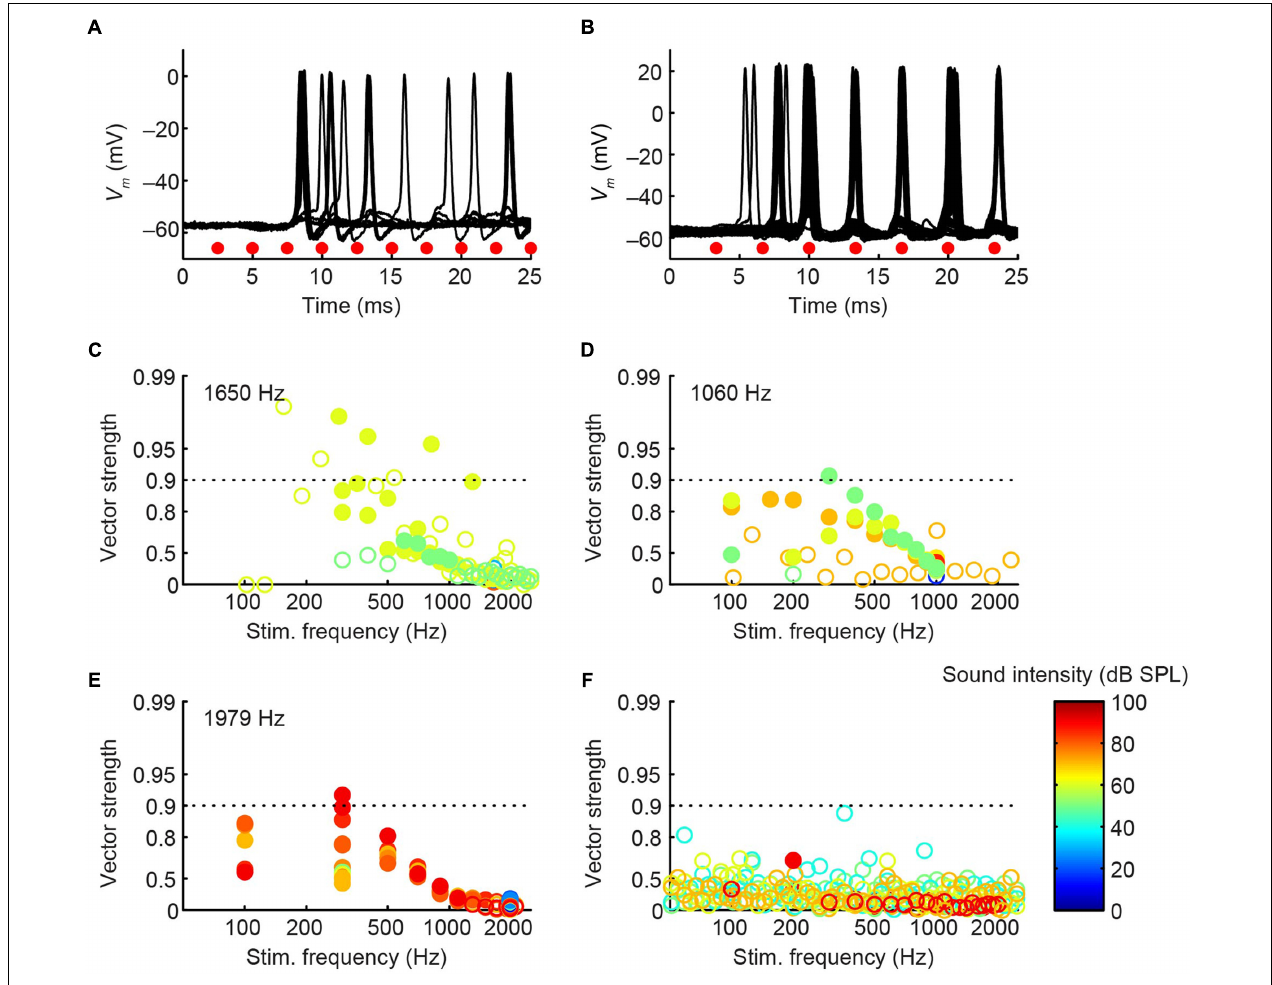
FIGURE 12 | Phase-locking of pvLNTB neurons to tones. (A) Stacked responses of a pvLNTB neuron to 400 Hz tones at 60 dB SPL (CF = 1650 Hz). Red dots indicate stimulus periods. VS is 0.78 ( α ≤ 0.001). (B) Responses of another pvLNTB neuron (CF = 1060 Hz) to 300 Hz tones at 50 dB SPL. VS is 0.91 ( α ≤ 0.001). (C–F) VS as a function of stimulus frequency for four pvLNTB neurons. (C) Corresponds to the neuron in (A,D) corresponds to the neuron in (B) . Filled symbols correspond to data with significant phase-locking. Colors indicate sound levels (scale in F ). CF, if known, is indicated in the panel. Note that the ordinate uses an expansive, approximately isovariance, scale, where (1-VS) is plotted on an inverted log axis (Johnson, 1980; Joris et al., 1994a). Dashed horizontal line indicates a VS of